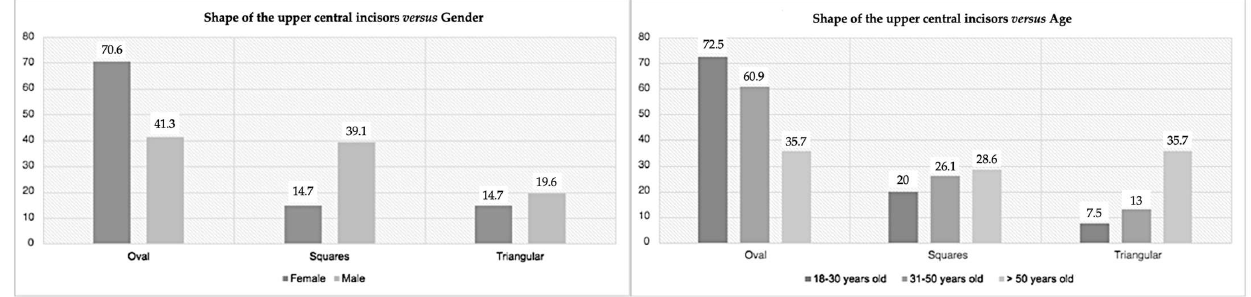
Figure 7. Prevalence of the shape of the upper central incisors according to gender ( left ) and age ( right ). Table 2. Predominant values found for the variables analyzed per group.